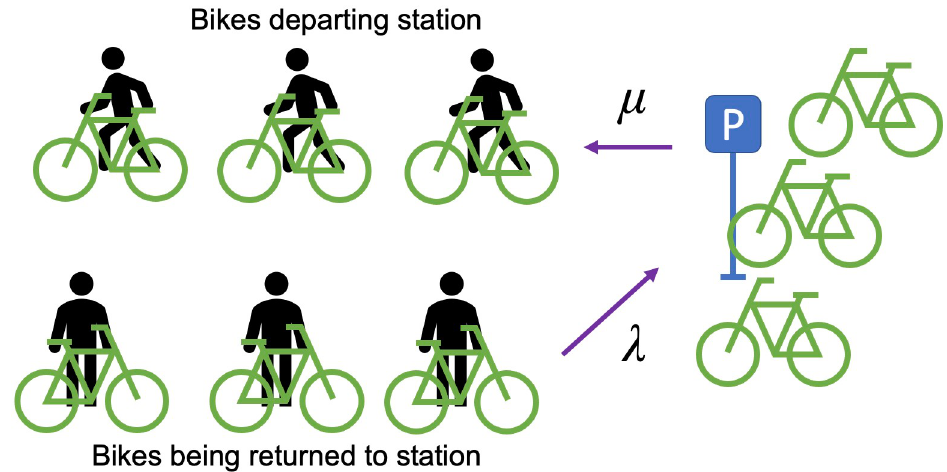
Fig 1. Bike departure and arrival event flows at a bike station.